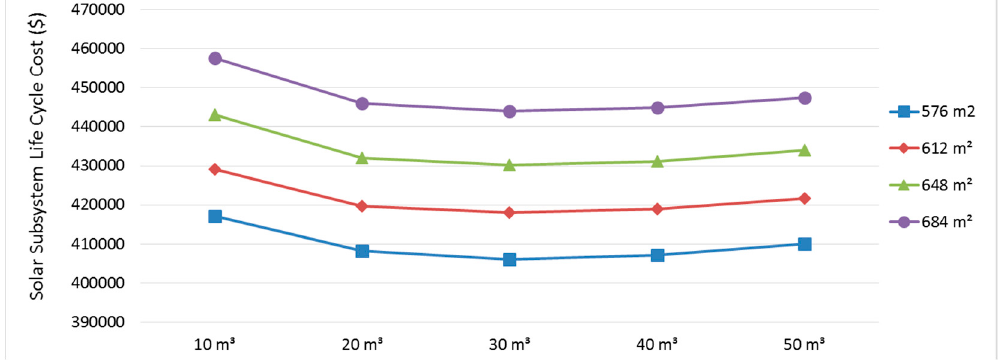
Figure 16. Solar subsystem LCC vs. storage tank volume and collector area. Table 5. Cost of different components and economic parameters [35].